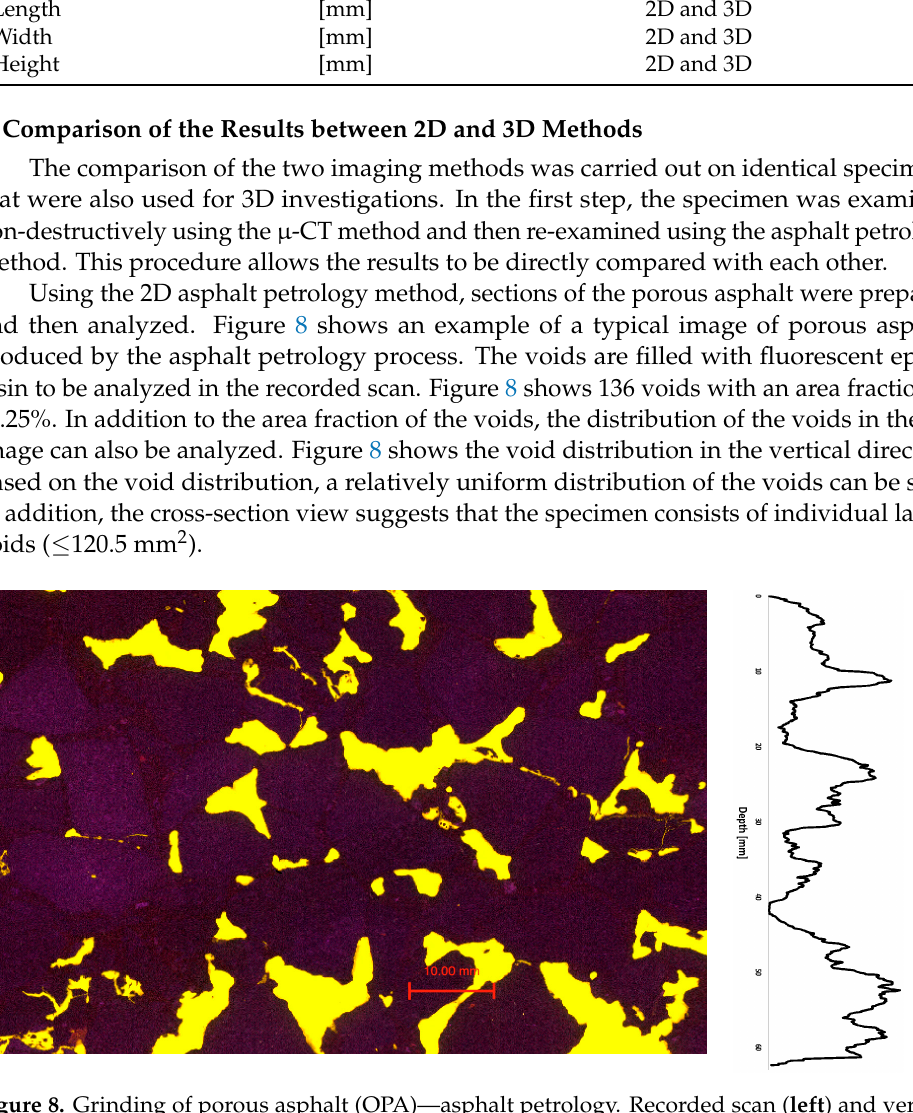
Figure 9. Visualized void distribution of the µ-CT scan—porous asphalt; volume: 48,593.1 mm 3 . In addition to porous asphalt, asphalt concrete was also investigated in this study. Figure 10 shows an example of a cross-section of the asphalt concrete investigated. Based on the 2D section, many small voids ( ≤ 30.13 mm 2 ) can be identified. The cross-section shown in Figure 10 shows 1079 voids with a total area of 7.71%.